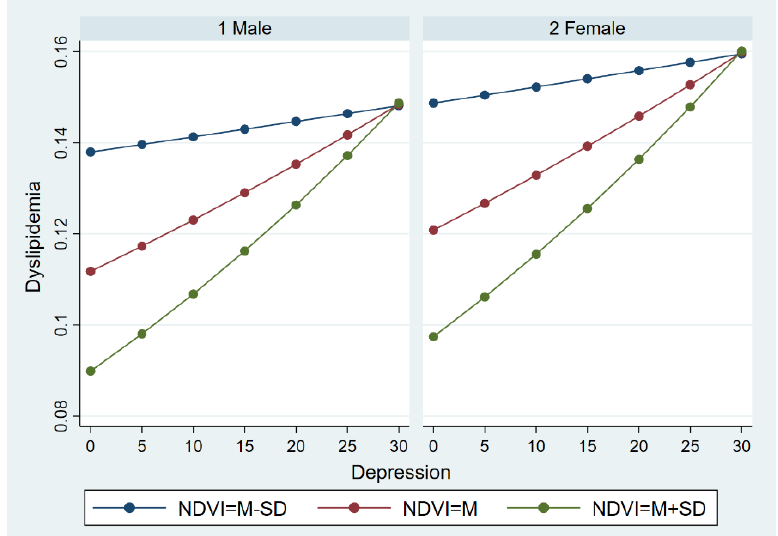
Figure 6. The moderate effect of NDVI on the relationship between depression and dyslipidemia across gender groups.